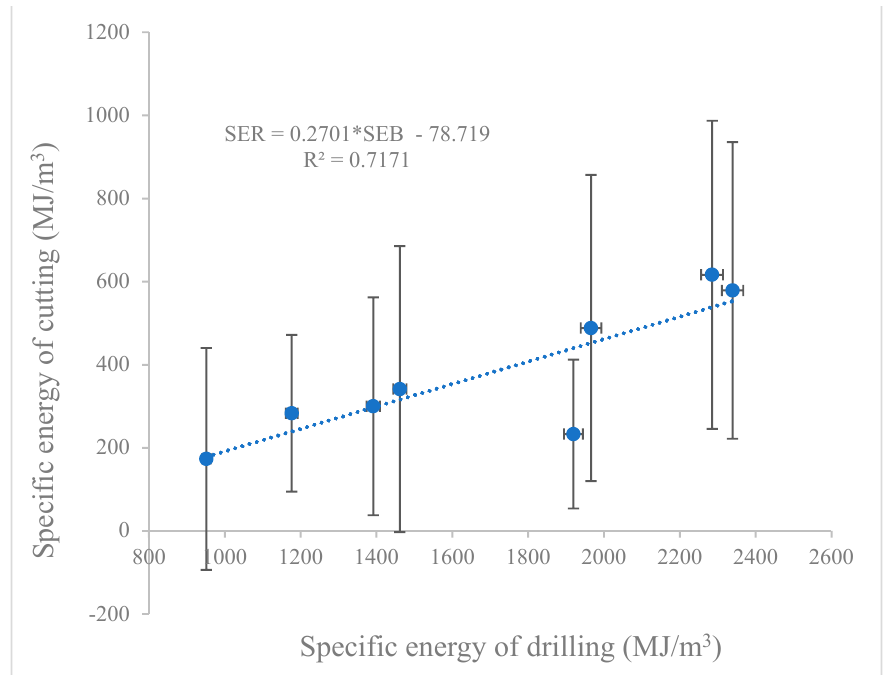
Figure 7. Diagram of the dependence of the specific rock cutting energy on the specific drilling energy (electrical power measuring system) by groups.